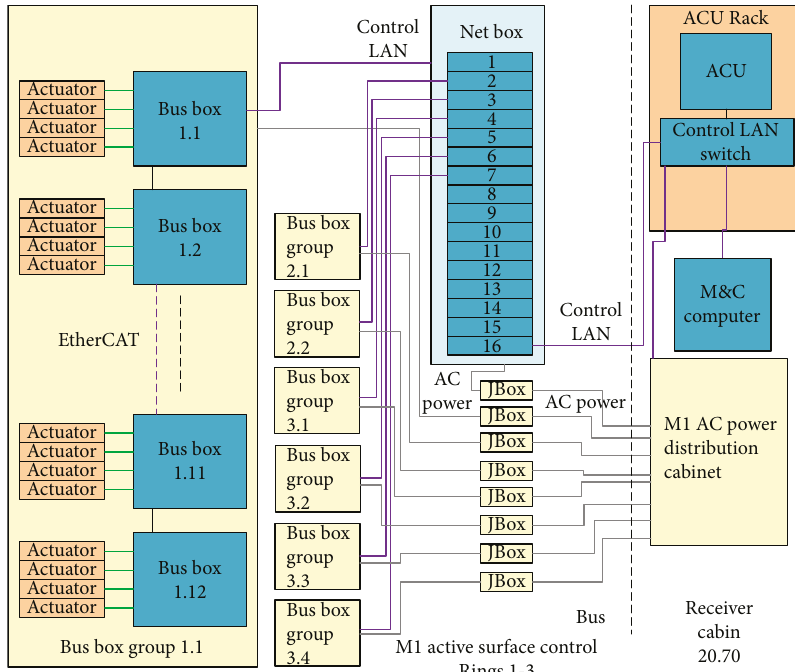
Figure 8: Con fi guration diagram of the LMT active surface control system [64].